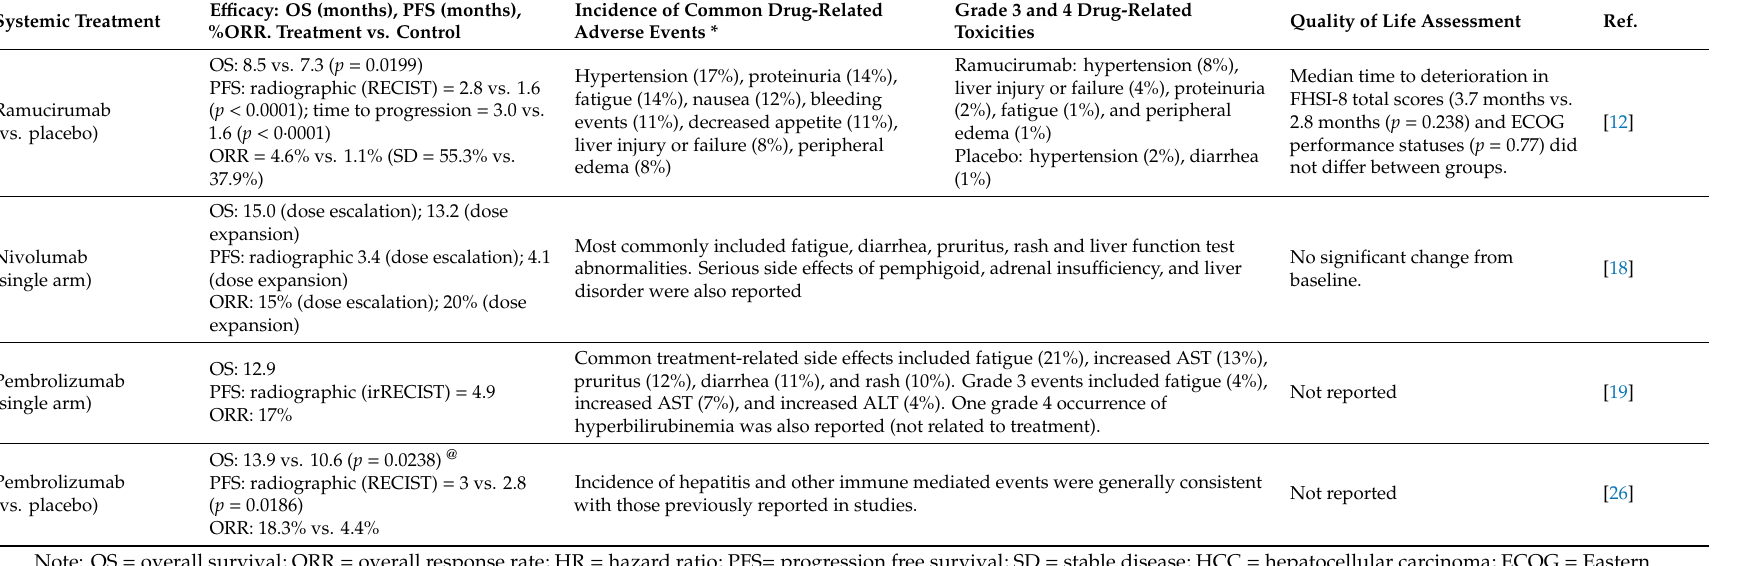
Quality of Life Assessment